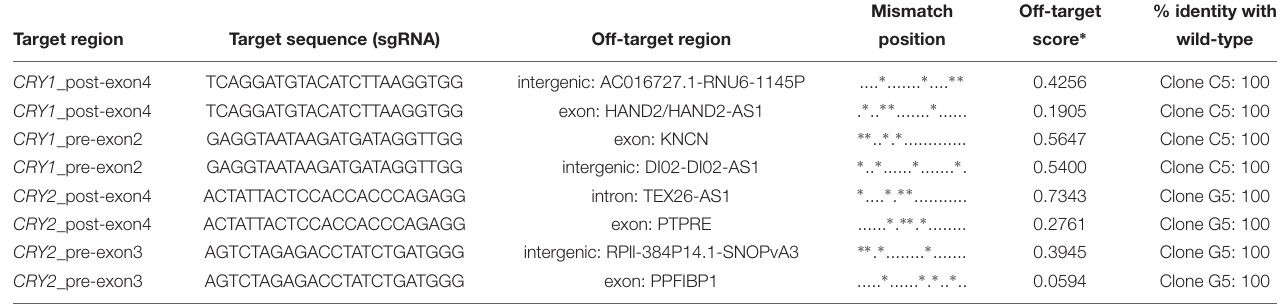
Mismatch Off-target % identity with